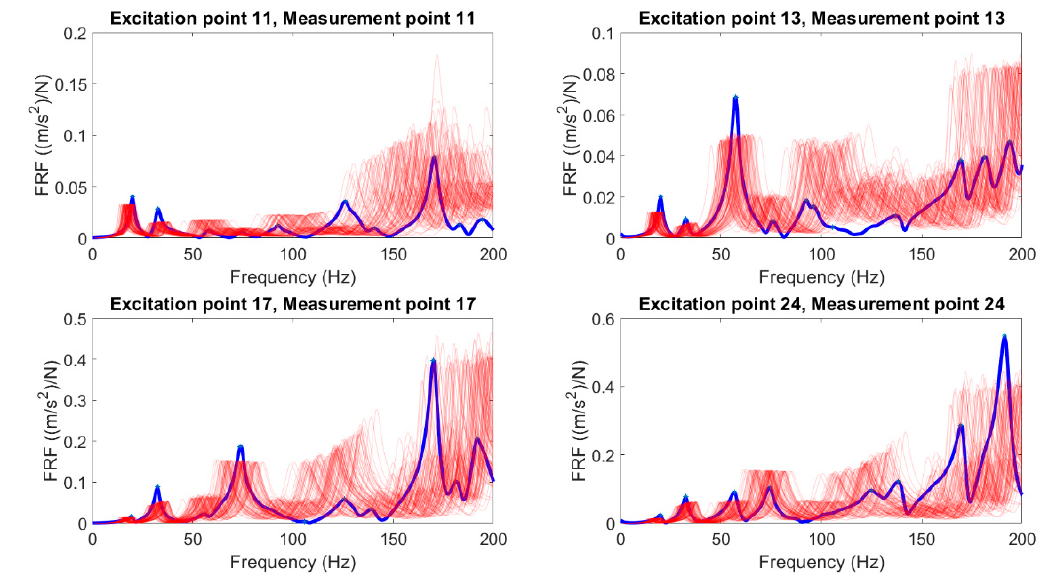
Figure 13. Measured (blue) and simulated (red) FRFs at point 11, 13, 17, and 24.